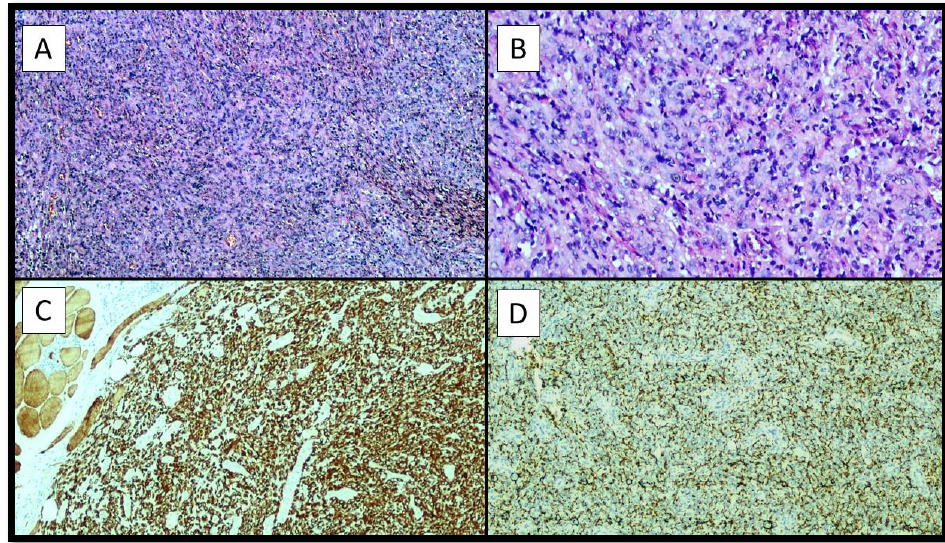
Figure 2. The histopathological analysis allowed to appreciate a lesion characterized by a peripheral fibrous pseudocapsule, not continuous, and by a large central cystic-haemorrhagic portion, consisting of medium-sized cellular elements ( A ), partly epitheliomorphs, sometimes with clarified cytoplasm ( B ), and in some areas spindle, mostly monomorphic, with evident eosinophilic nucleoli, with solid growth ( B ). A rich inflammatory infiltrate was described, also consisting of foamy histiocytes and hemosiderophages. The mitotic count was 2/10 high power field (HPF) and there were no areas of necrosis. The immunohistochemical reactions were positive for Desmin with a score of +++ ( C ), CD68 PG-M1 positive with a score of ++/ − ( D ). Reactions for Epithelial Membrane Antigen (EMA), S-100 protein, Miogenin and MyoD1 and CD34 were negative. The fraction of neoplastic proliferation evaluated by Ki67 + was low, around 5–6%. The diagnosis of Angiomatoid Fibrous Histiocytoma (AFH) was then made and the patient was closely followed-up. After less than 6 months, the patient was again subjected to a surgical resection, whose histological sample was analyzed and found to be an intramuscular localization of AFH with free margins. After about 12 months, the patient returned to the referring physician with progressive febrile episodes and asthenia, as well as mild breathing difficulties. A new CT was performed which showed a thickening of about 0.8 cm. An apical resection of the upper lobe of the right lung (LSD) was